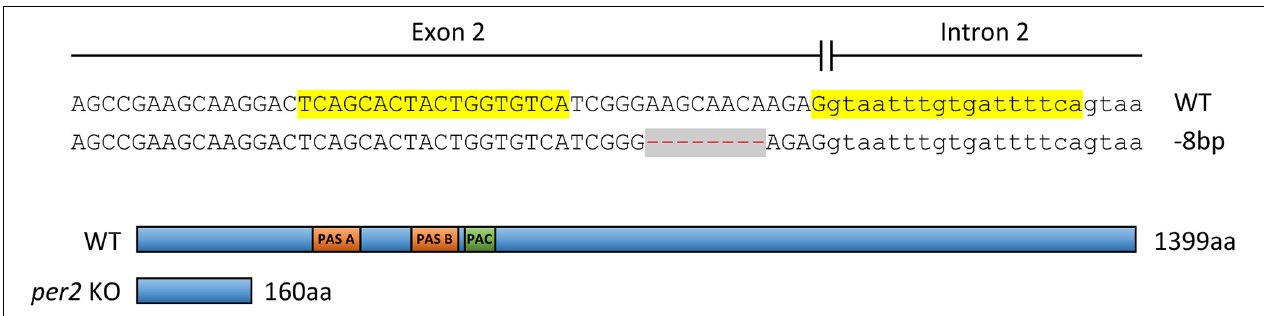
FIGURE 1 | Above: Establishment of a TALEN-mediated per2 KO zebrafish line. A pair of TALENs was used to target the 2nd exon of the zebrafish per2 gene (TALEN left and right target sites are highlighted in yellow). A deletion of 8 bp (red dashes against a gray background) resulted in a frameshift mutation. Below: The consequent introduction of a premature stop codon and a predicted truncated PER2 protein of 160 aa compared with the 1399 aa WT protein. PER-ARNT-SIM domains (PAS, orange) and C-terminal of PAS domain (PAC, green) in the WT protein are indicated.